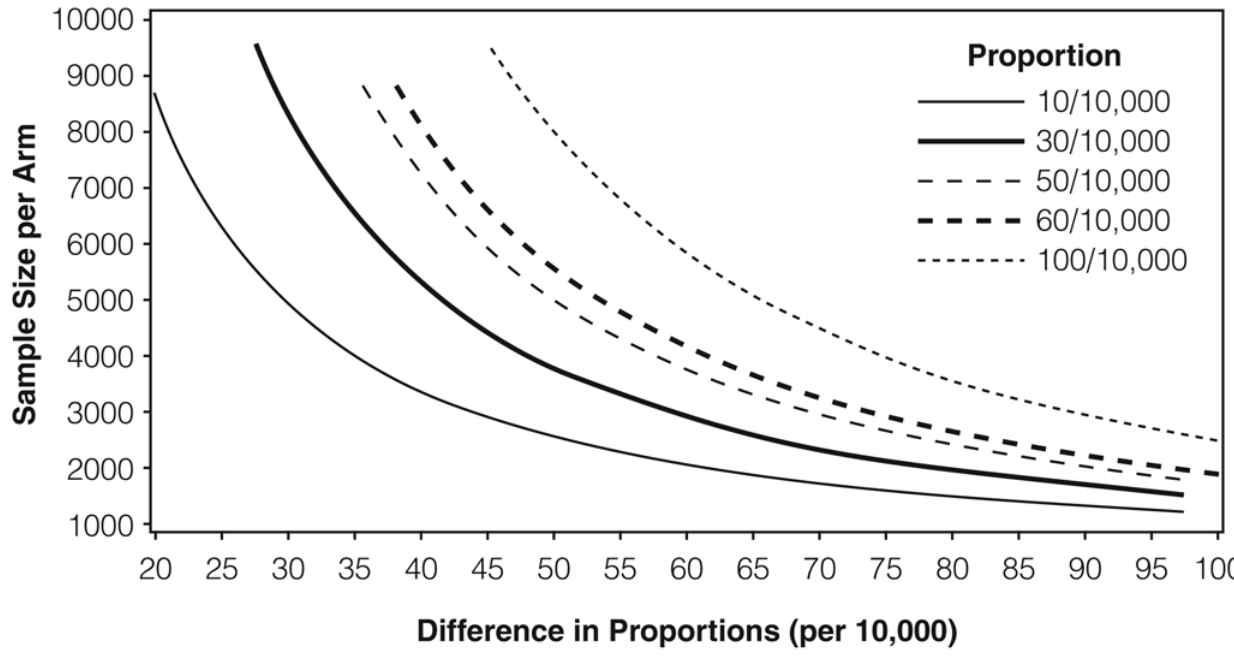
Figure 2. Sample size curves: Hypothesis testing method (Formula 3) at 80% power and a of 0.05 (two-tailed), showing sample sizes needed to distinguish among groups for given baseline error rates and assumed differences (Fleiss J, Levin BL, Paik M. Statistical Methods for Rates and Proportions. 3 rd ed. New York, NY: Wiley; 2003).